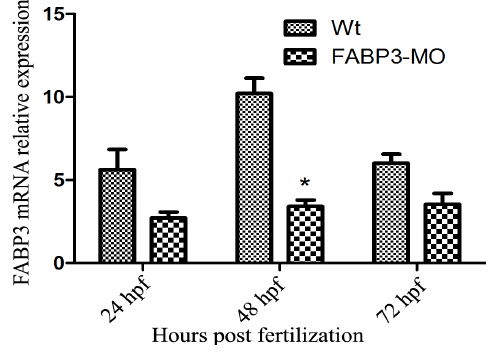
Figure 1. Expression of FABP3 is downregulated in FABP3-MO injected zebrafish. Quantitative PCR validation of FABP3 expression in FABP3-MO injected zebrafish at 24, 48 and 72 hpf and Wt-MO injected zebrafish. Data are representative of three independent experiments; data are expressed as the means ± SD; n = 50 zebrafish embryos per group. * p <